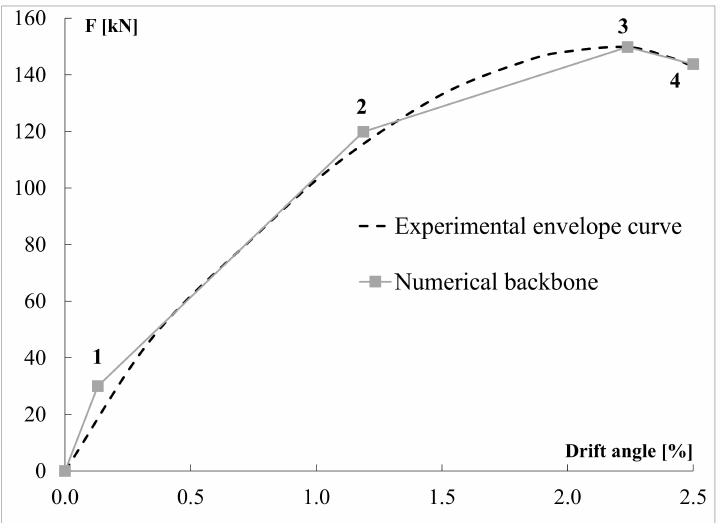
Figure 2. Comparison between experimental and numerical envelope curves for the wall located at third